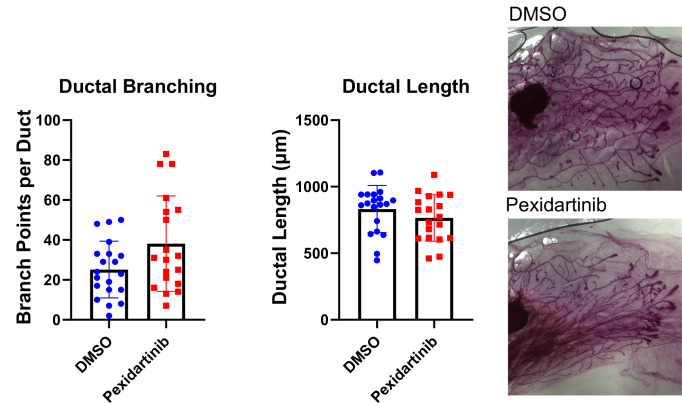
Macrophage depletion does not impact ductal elongation of branching.Quantification of ductal elongation and branching in mammary glands from mice treated with either solvent or pexidartinib for 2 weeks. Ductal Branching DMSO vs pexidartinib, p=0.1081; Ductal Length DMSO vs pexidartinib, p=0.1661. P values generated using Mann-Whitney U Test.